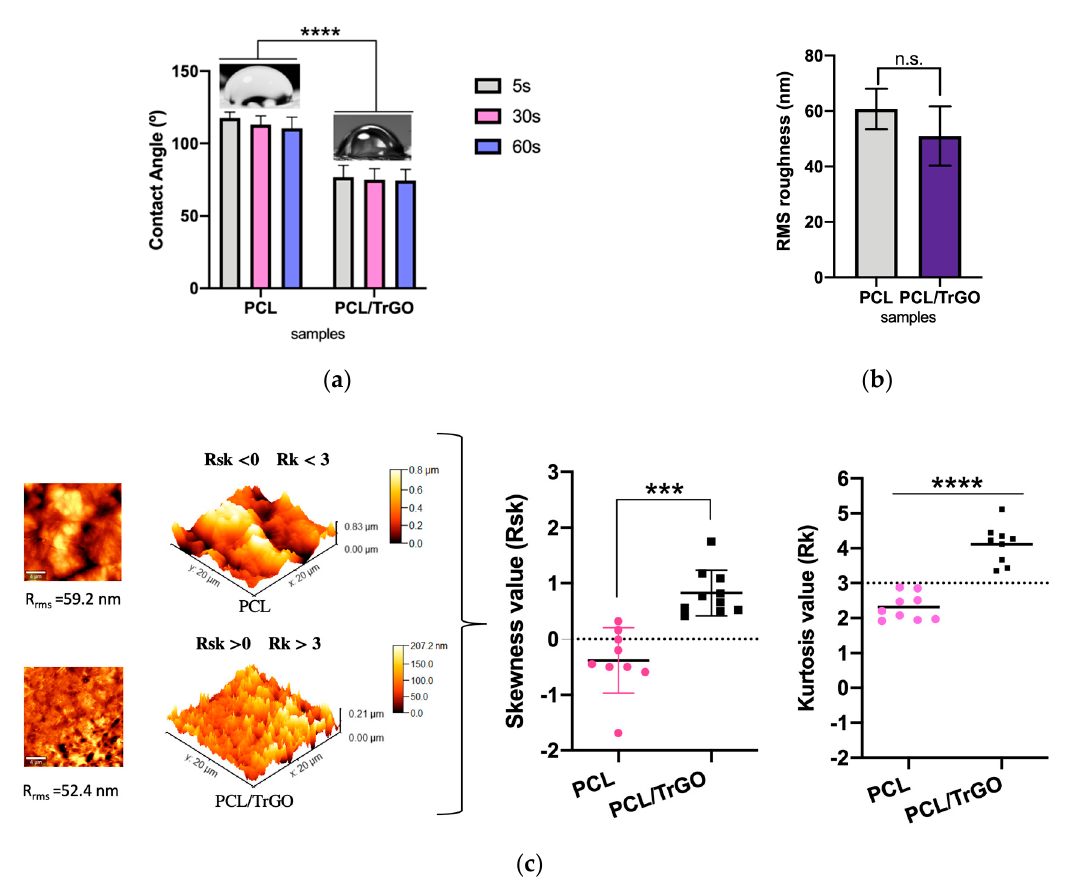
Figure 6. ( a ) Contact angle measurement for PCL and PCL/TrGO scaffolds. **** denotes a significant difference with a value p < 0.0001 between the samples indicated (n = 5 independent tests performed for each time spent); ( b ) RMS roughness values of PCL an PCL/TrGO scaffolds, n.s. denotes nonsignificant difference between the samples (n = 5 different zones of measurements); ( c ) AFM micrograph of surface roughness and topography of PCL scaffolds and PCL/TrGO scaffolds (n = 5 independent measurements) (left), graphs of skewness (Rsk) and kurtosis (Rk) values of PCL and PCL/TrGO samples (right). *** and **** denote a significant difference with a value p < 0.001 and p < 0.0001, respectively, between the samples indicated.